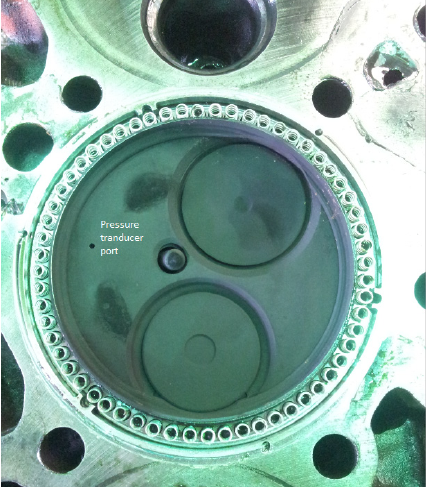
Figure A2. Detail of the cylinder head modification. Note that the seal gland area is completely free from carbon